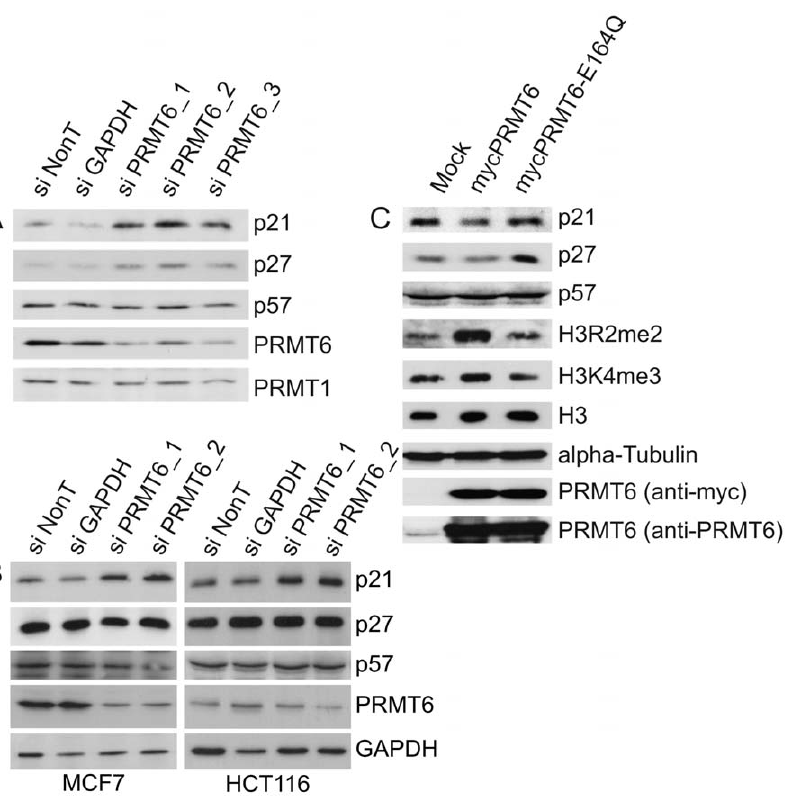
Figure 1. Knockdown of PRMT6 results in upregulation of p21. (A) U2OS cells were transfected with the indicated siRNAs. After 72 hours cells were harvested and immunoblot analysis was performed using antisera against PRMT6, PRMT1, p21,p27 and p57. (B) MCF7 (right panel) or HCT116 (left panel) cells were transfected with the indicated siRNAs. After 72 hours cells were harvested and immunoblot analysis was performed using antisera against PRMT6, p21, p27, p57 and GAPDH. (C) U2OS cells were transfected with expression constructs for pcDNA3-PRMT6 wild type and pcDNA3-PRMT6-E164Q or untreated (mock). After 48 hours cells were harvested and analysed with the indicated antisera.